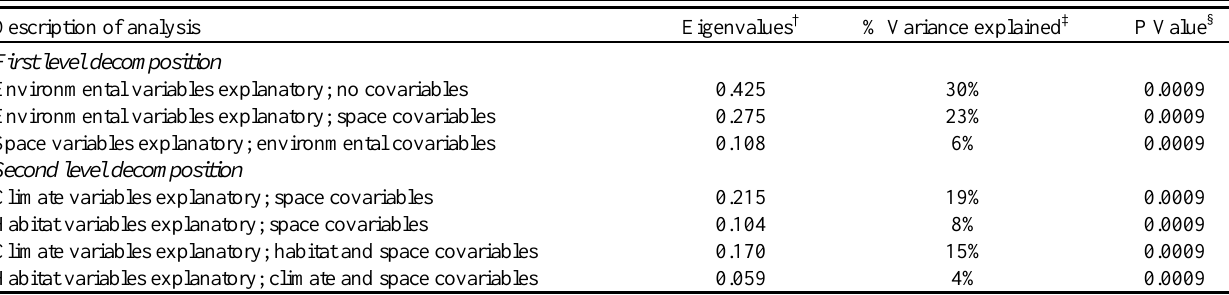
Table 2 . Summary of results of first and second level partial-RDA conducted to partition the percent variance in the distribution of birds explained by environmental variables and spatial variables (first level), and climate and habitat (second